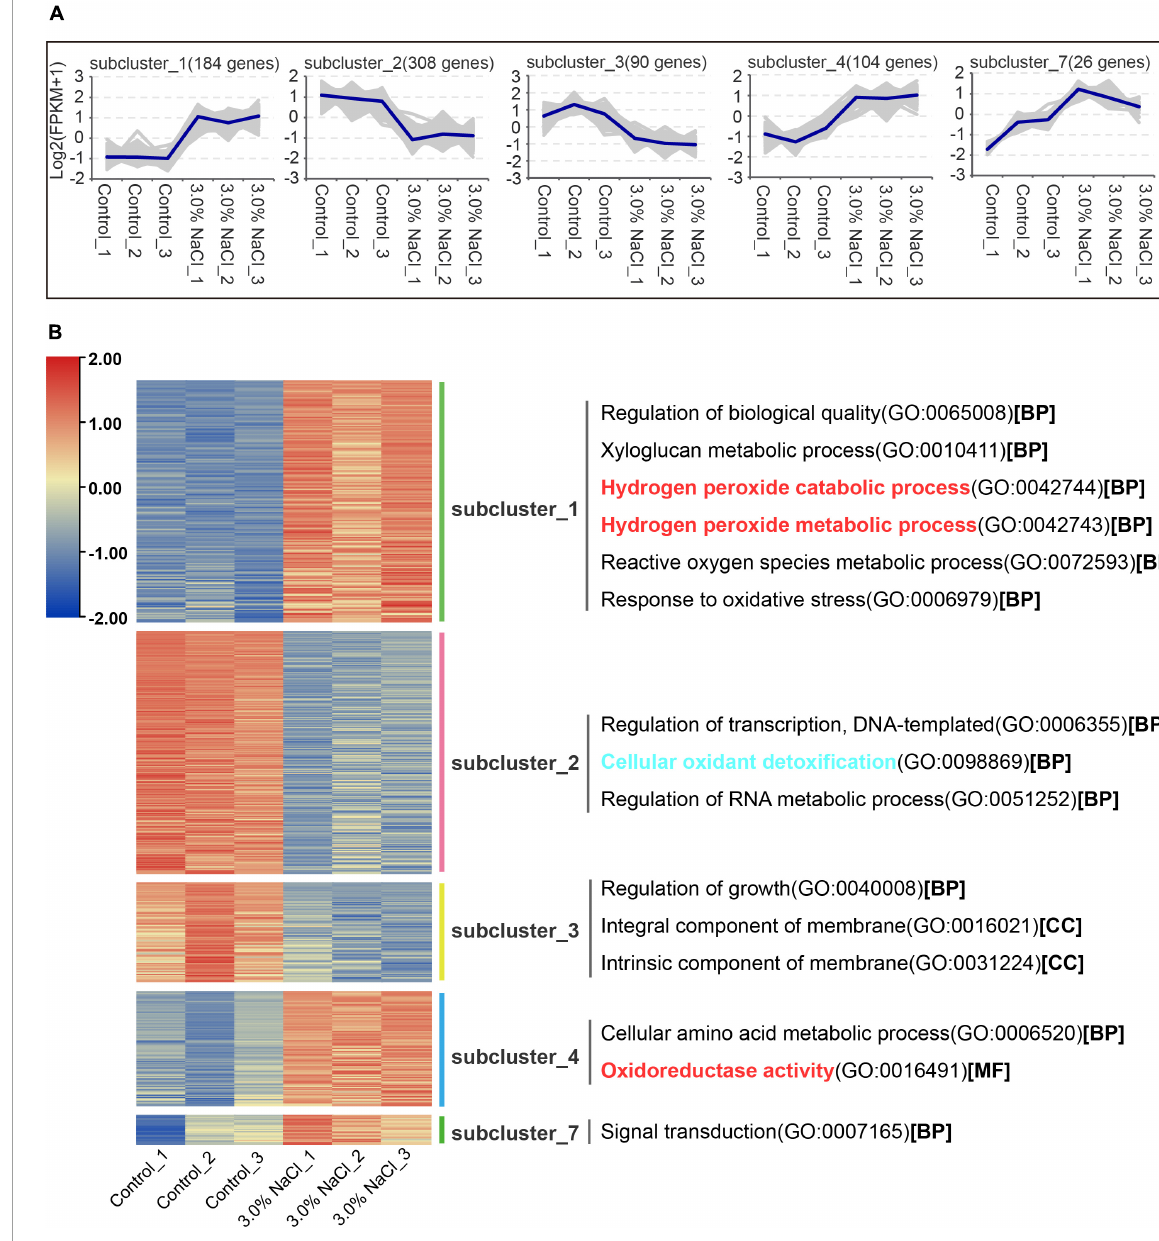
FIGURE5 Gene co-expression clusters and heatmap analysis of DEGs in S. caseolaris under 3.0% NaCl treatment. (A) Gene number of co-expression clusters and these gene expression patterns, (B) heatmap and GO terms related to clusters of enriched gene co-expression.